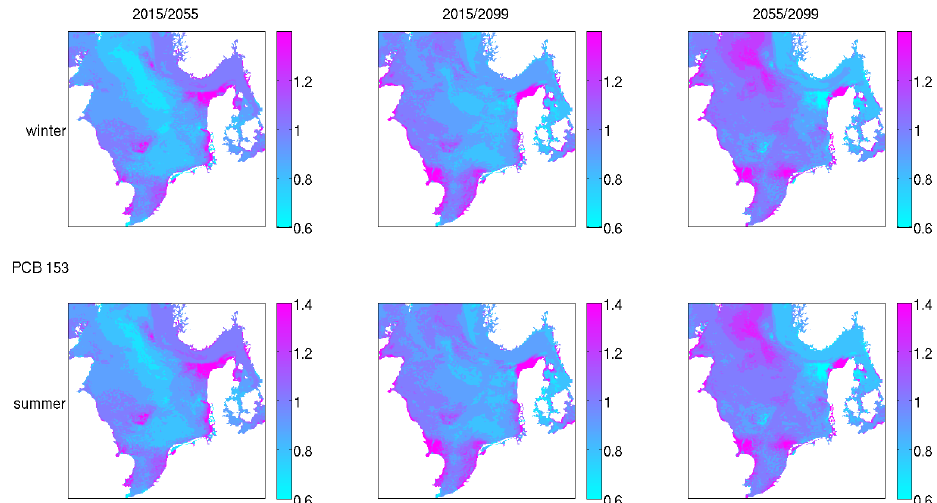
Figure 10. Distributions of concentration ratios of PCB 153 in sediment at the end of the three runs, 2015/2055, 2015/2099 and 2055/2099, from left to right, respectively, in winter (top) and summer (bottom). Units are ngg − 1 dry